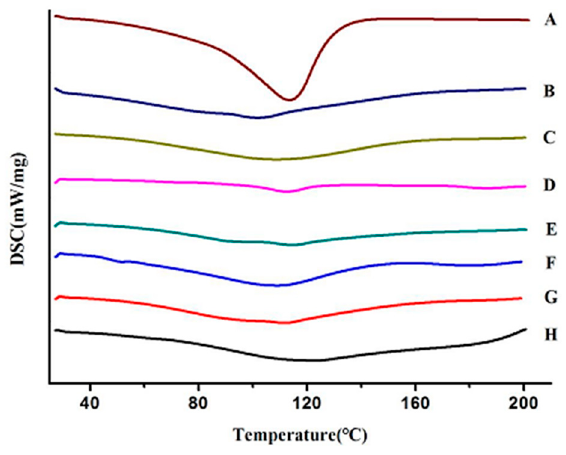
Figure 6. Thermograms of different materials. A: β -CD; B: GEO/ β -CD composite; C: Chitosan; D: STPP; E: Physical mixture (with STPP); F: GEO/ β -CD/CTS particles; G: Physical mixture (without STPP); H: GEO/ β -CD/CTS microsphere.